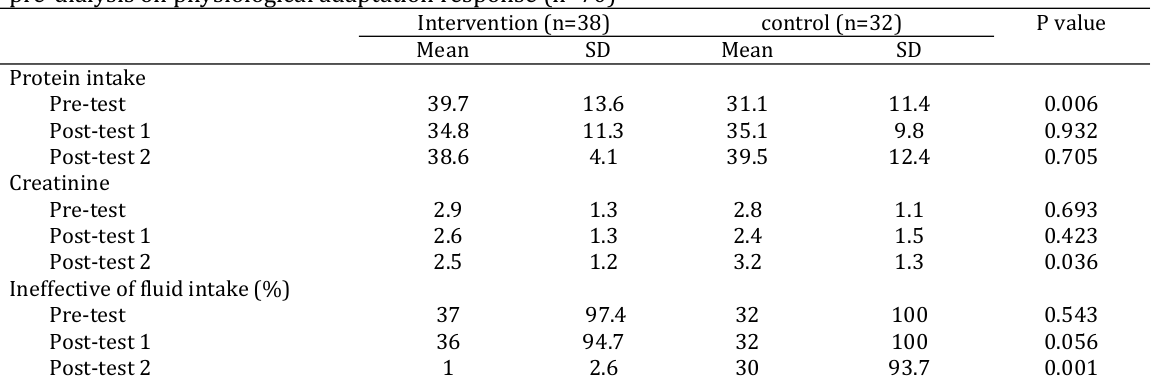
Table 2. The effectiveness of Roy’s adaptation behaviour for patients with chronic kidney disease undergoing pre-dialysis on physiological adaptation response (n=70)